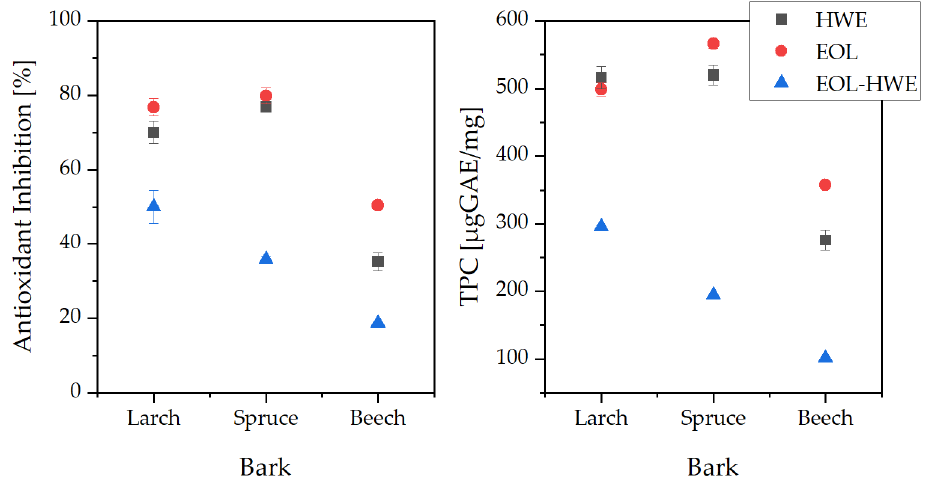
Figure 3. Antioxidant inhibition ( left ) and total phenolic content ( right ) of bark extracts. Standard deviation indicated by error bars.